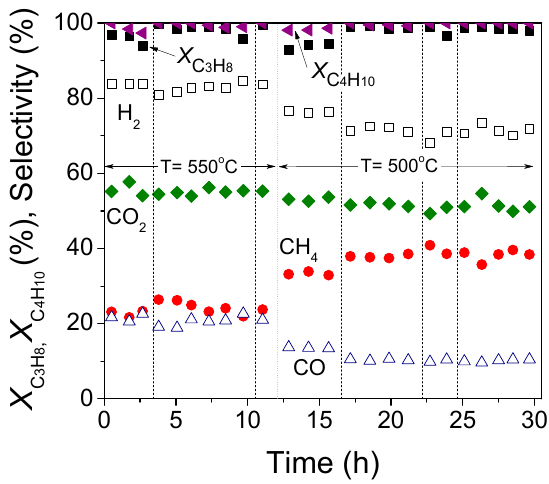
Figure 13. Long-term stability test of 0.5%Rh/TiO 2 catalyst in the form of pellets at T = 550 and 500 °C: Alterations of the conversion of C 3 H 8 and C 4 H 10 , and selectivities toward reaction products with time-on-stream. Experimental conditions: Same as in Figure 12. Dashed vertical black lines indicate shutting down of the system overnight. Dashed vertical red line indicates switch of temperature from 550 to 500 °C.